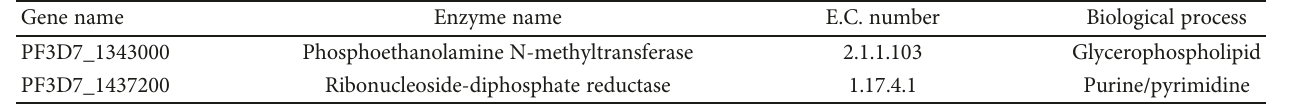
Figure 7: (a) Predicted pentose phosphate pathway. (b) Predicted essential pentose phosphate pathway. Table 4: Predicted essential genes with no homologs in the human